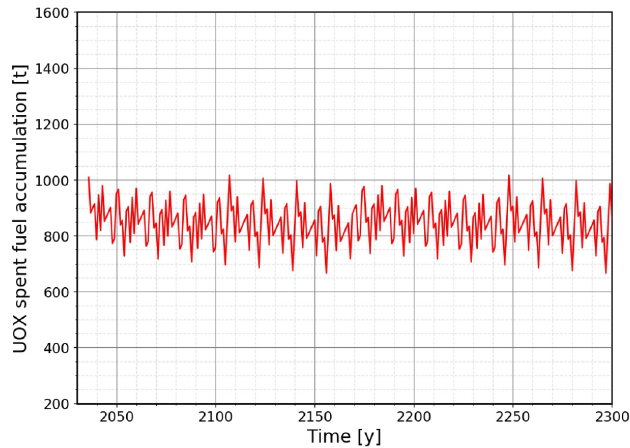
Fig. 4. COSI6 UOX spent fuel accumulation.